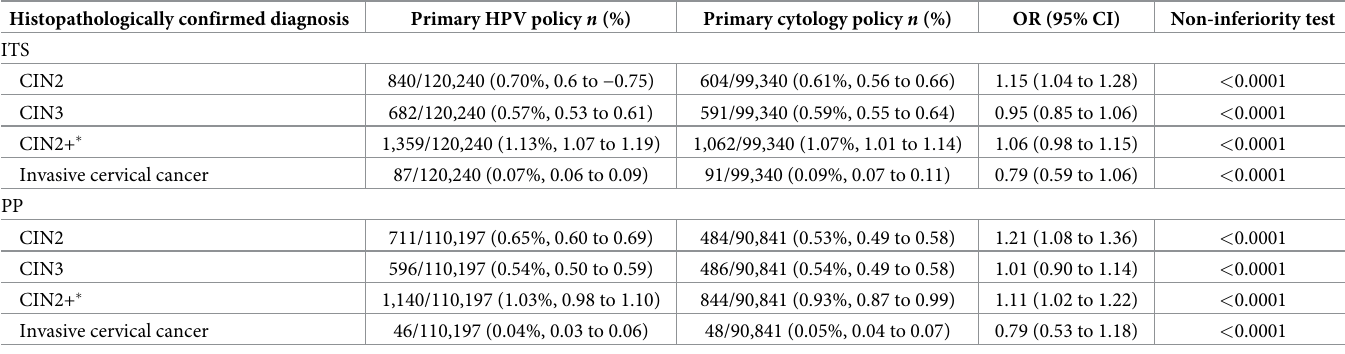
Table 5. Histopathology outcomes and overall detection rates by analysis and study arm. Histopathologically confirmed diagnosis